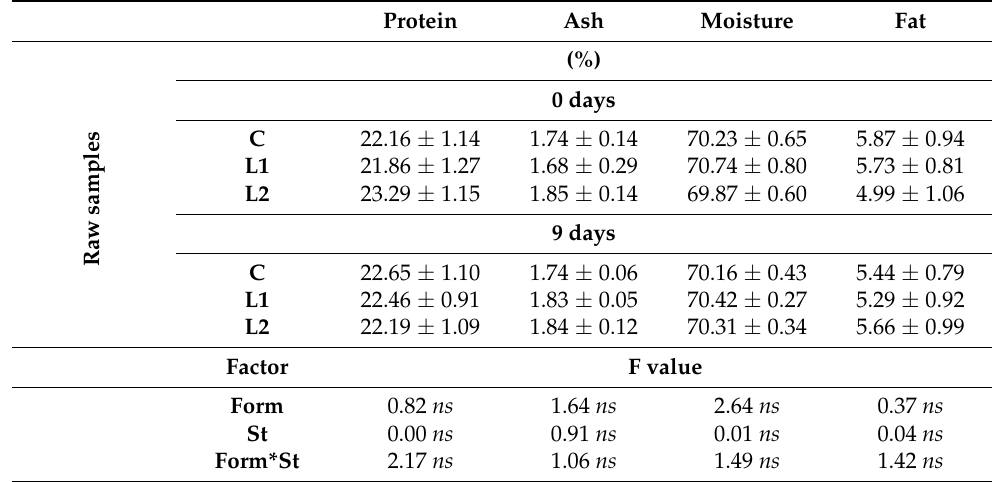
Table 1. Proximate composition of raw hamburger samples after 0 and 9 days of storage. C, Control (minced beef meat + maltodextrin + starter cultures); L1, minced beef meat + starter cultures + 87.5